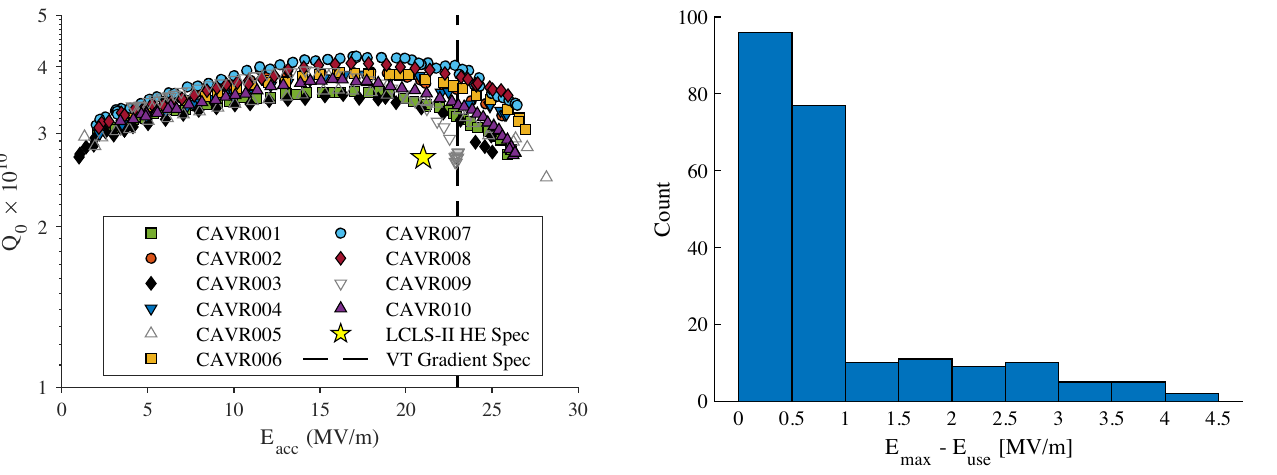
FIG. 3. Vertical test qualification of ten cavities tested for FIG. 4. Histogram of the maximum gradient minus the usable the vCM. All ten qualified and eight were selected (open gradient for L2 cavities without excessive field emission, HOM symbols indicate the two not selected). Measurements were port heating, or similar limiting extrinsic performed at 2 K. Uncertainty in Q 0 and E measurements is acc approximately 10%.